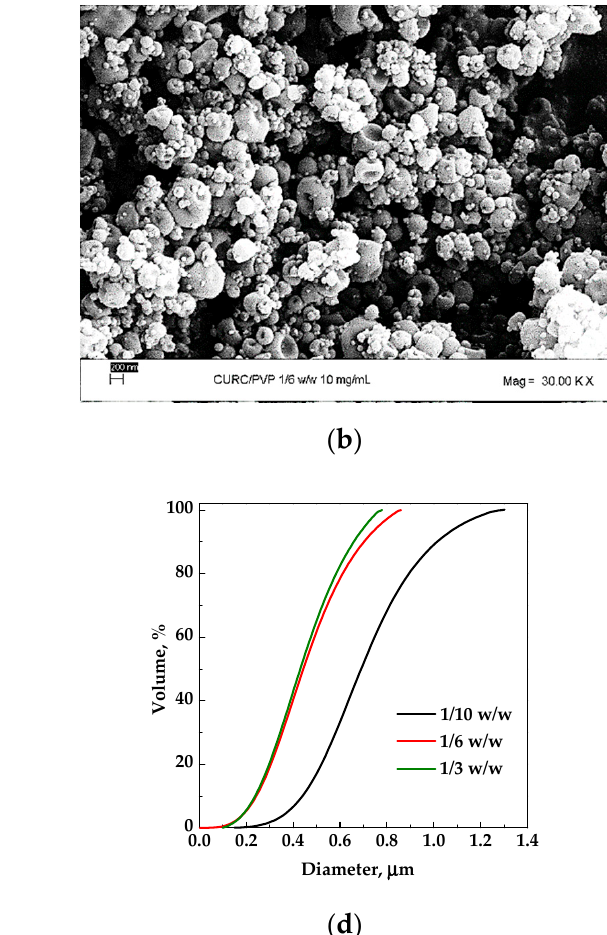
Figure 2. PVP/CUR particles produced by SAA from EtOH at 10 mg/mL. Effect of the carrier/API ratio: ( a ) 10/1 w / w ; ( b ) 6/1 w / w ; ( c ) 3/1 w / w ; ( d ) particle size distribution of the powders obtained under different conditions.